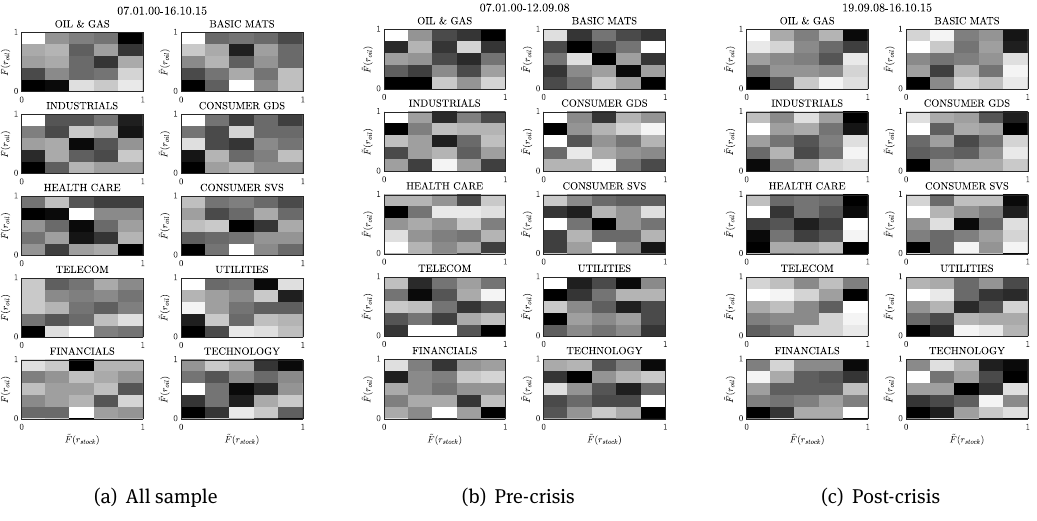
Figure 3: Empirical joint distribution for returns of EUROSTOXX sector portfolios and Brent oil denominated in Euros. Left set of subfigures show the empirical joint distribution function for all the sample, centre set of graphs represents the pre- crisis subsample and the right one the post-crisis subsample. Darker colours indicate a higher data clustering on certain part of the distribution. Looking at the entire sample and assessing a constant copula parameter may overlook the complex depen- dence evolution within the